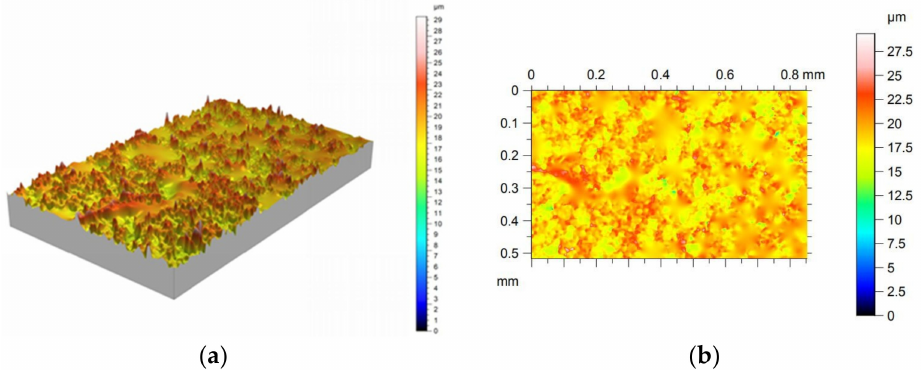
Figure 4. ( a ) 3D Surface topography of Region 3 as measured using the optical profilometer; ( b ) top view of the measured